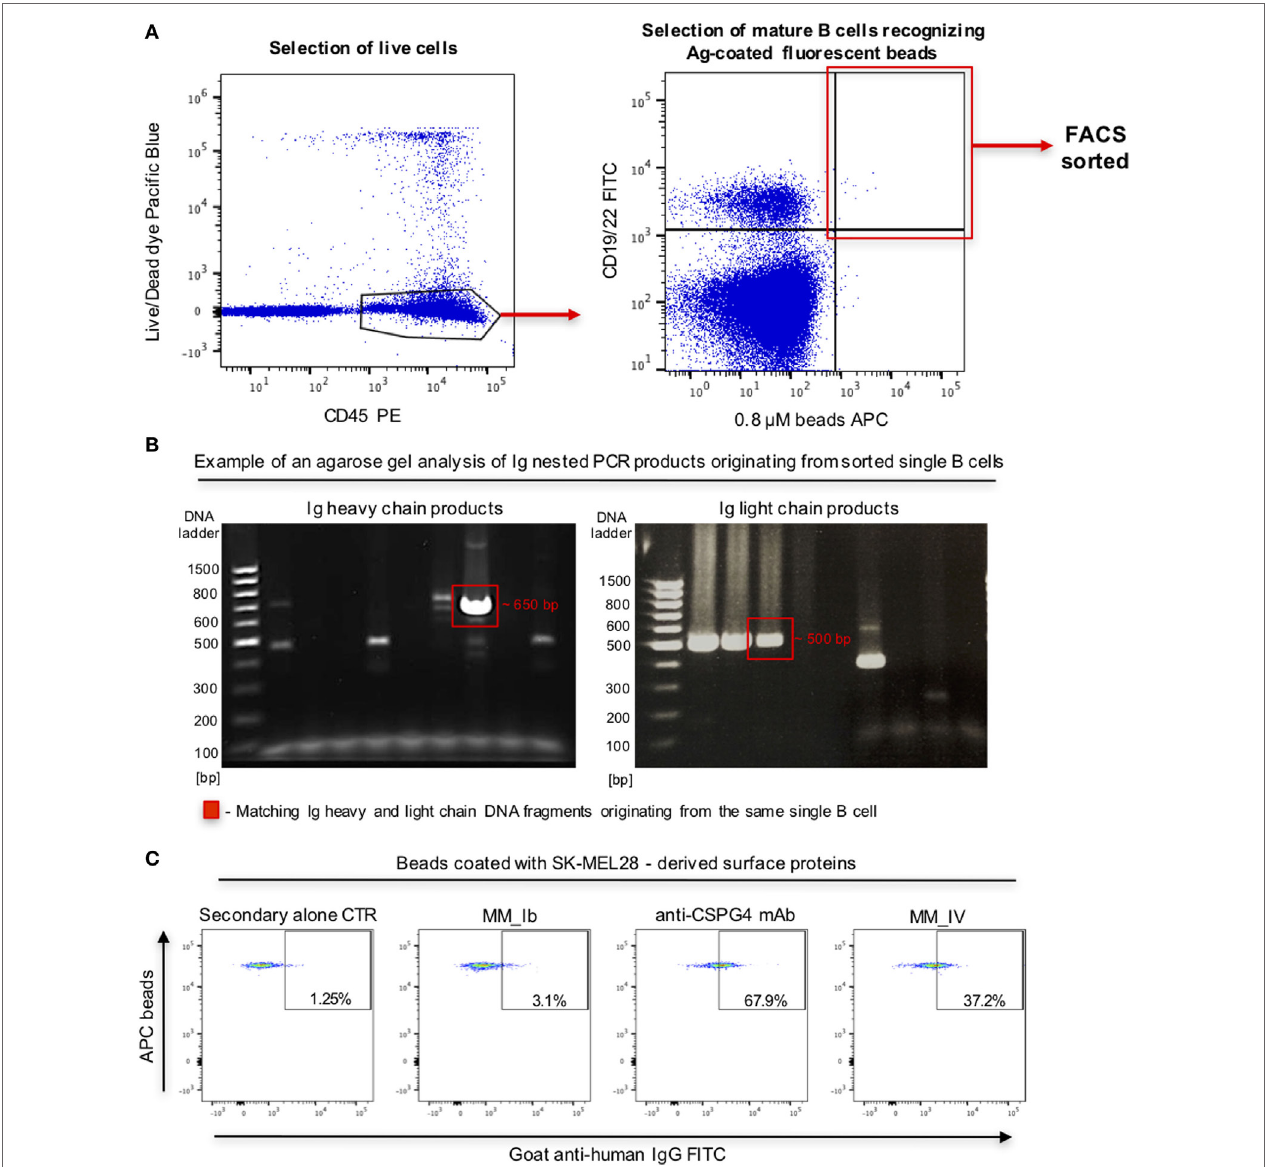
FigUre 8 | Selection of antibody-expressing B cells in peripheral blood mononuclear cells (PBMC) samples from patients with melanoma. (a) Representative flow cytometric dot plots of cell sorting gating strategy to select melanoma patient B cells recognizing melanoma cell line surface antigen (Ag)-coated fluorescent beads. Viable (live/dead dye) human CD45 + PBMC incubated with antigen-coated beads were identified (left) and B cells (CD19/CD22 + -FITC) recognizing antigen-coated beads (APC) were selected for single cell sorting (right). (B) Agarose gels of Ig heavy (left) and light (right) chain DNA fragments amplified through nested PCR. Each gel lane represents PCR products derived from a single B cell. Fragments of the expected sizes (~650 bp for the heavy chain, ~500 bp for the light chain fragments) were extracted and sequenced. Red boxes indicate matching Ig heavy and light chain DNA fragments originating from the same single B cell. (c) Flow cytometric dot plots depicting binding of two single B cell-derived monoclonal antibody clones (MM_Ib, MM_IV) to melanoma cell antigen-coated fluorescent beads (SK-MEL-28 melanoma cells). The bead-selected clone (MM_IV) bound to antigen-coated beads while the non-specific one (MM_Ib) did not show reactivity. Background binding was detected with secondary antibody alone, while beads were recognized by the positive control anti-CSPG4